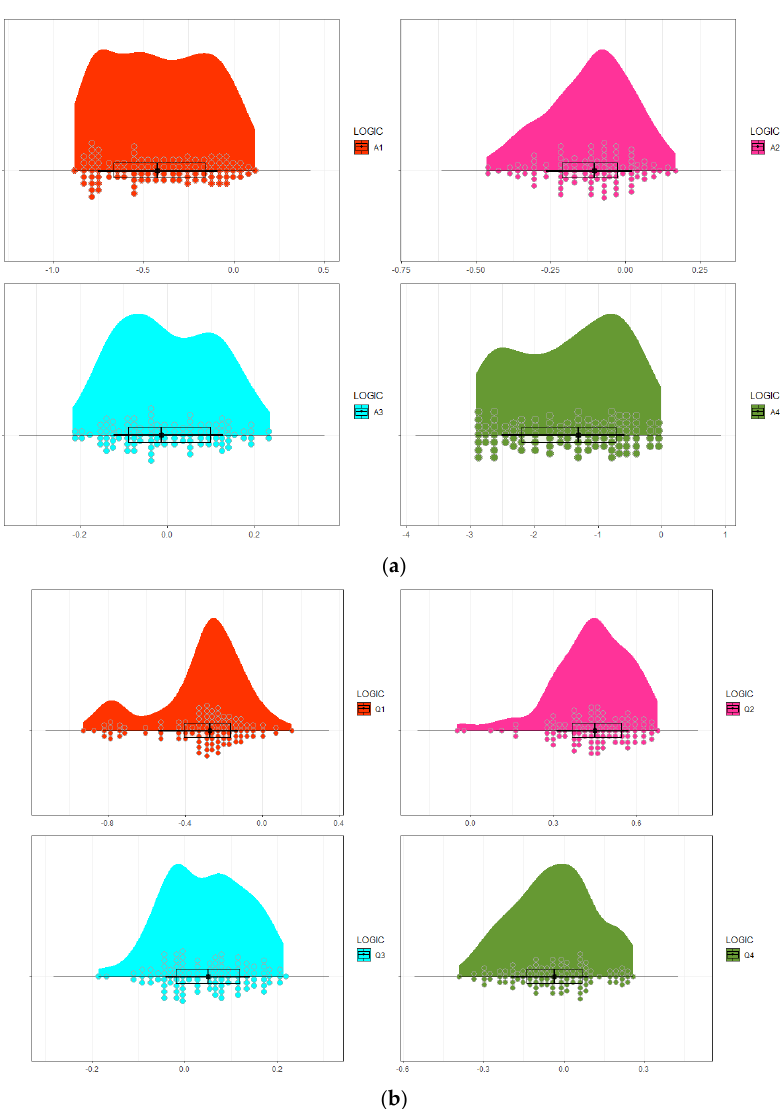
Figure 14. The Raincloud Plot analysis for ( a ) δ 1 2 SAT ρ , ( b ) δ 2 2 SAT ρ synaptic weight means when . Y =